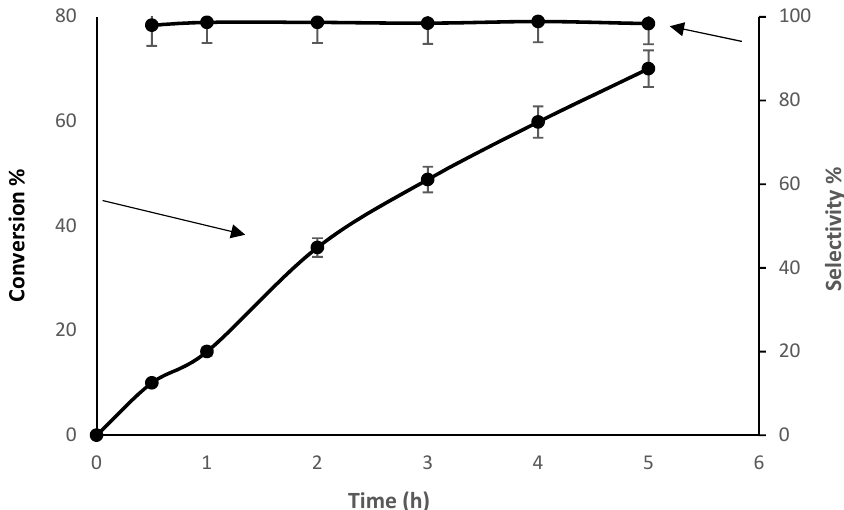
Figure 5. Effect of reaction time on the conversion of benzyl alcohol oxidation. The reaction includes 0.02 g catalyst and 2 gm of benzyl alcohol conducted at 120 ◦ C, O 2 (1 bar), stirred at 1000 rpm.